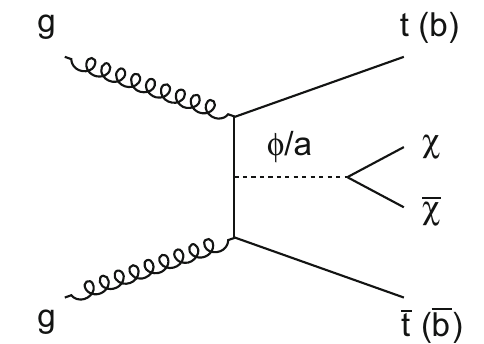
Fig. 1 A leading order Feynman diagram describing the production of a pair of DM particles ( χ ) with heavy-flavor (top or bottom) quark